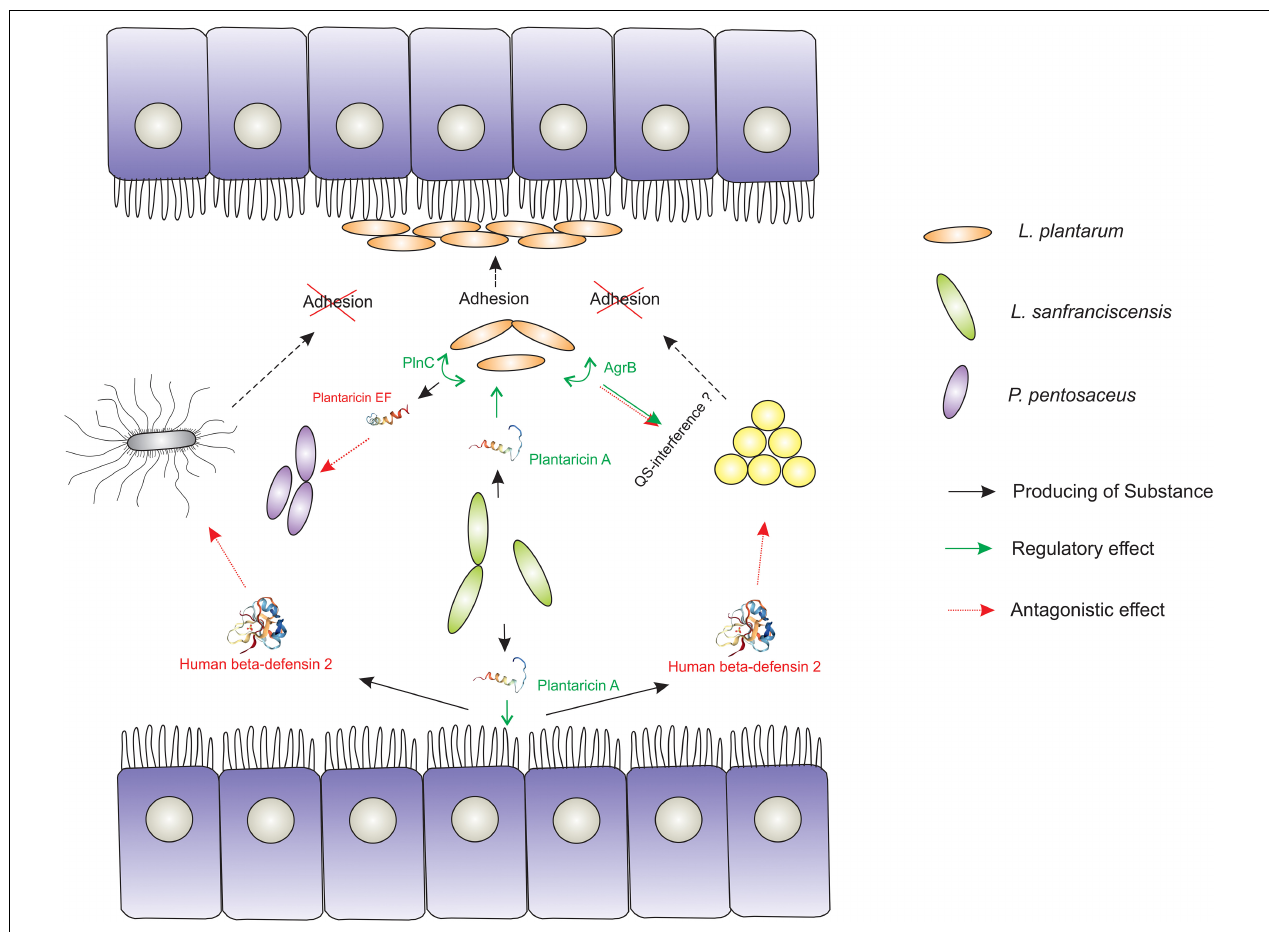
FIGURE 2 | Demonstration of the signaling role of bacteriocins in the formation of a sustainable mammalian gut microbiome. The Lactobacillus strain producing plantaricin A triggers the expression of genes and the production of metabolites that enhance the colonizing ability (adhesion and biofilm formation) of another Lactobacillus strain. The occupied econish is no longer available for pathogenic and conditionally pathogenic microorganisms ( S. aureus and S. typhimurium ). In addition, certain (PlnC) activators of bacteriocin production (Plantaricin EF, for example) and some component of the agr QS-system (AgrB) are launched in susceptible to PlnA Lactobacilli cells, which has a certain antagonistic effect on the competitor species. Also plantaricin A triggers the production of human β -defensin 2 of the intestinal epithelium, which potentially has an antagonistic effect on a number of pathogenic and conditionally pathogenic